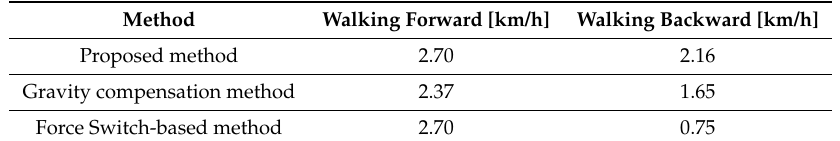
Table 1. Walking speed for each method.